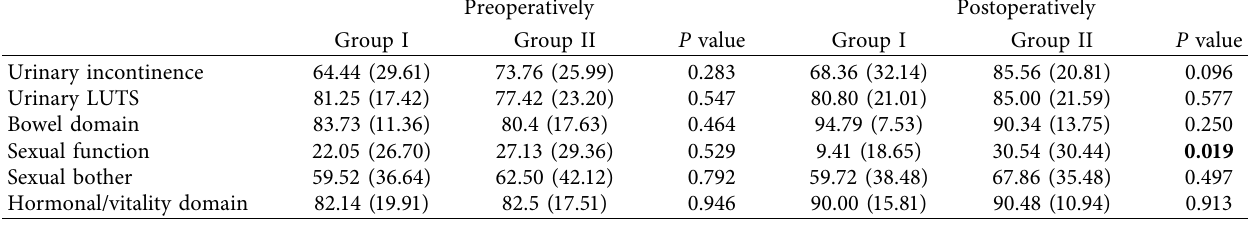
Table 4: The mean (SD) postoperative EPIC-26 scores of those without (Group I) and with (Group II) pseudotesticles.